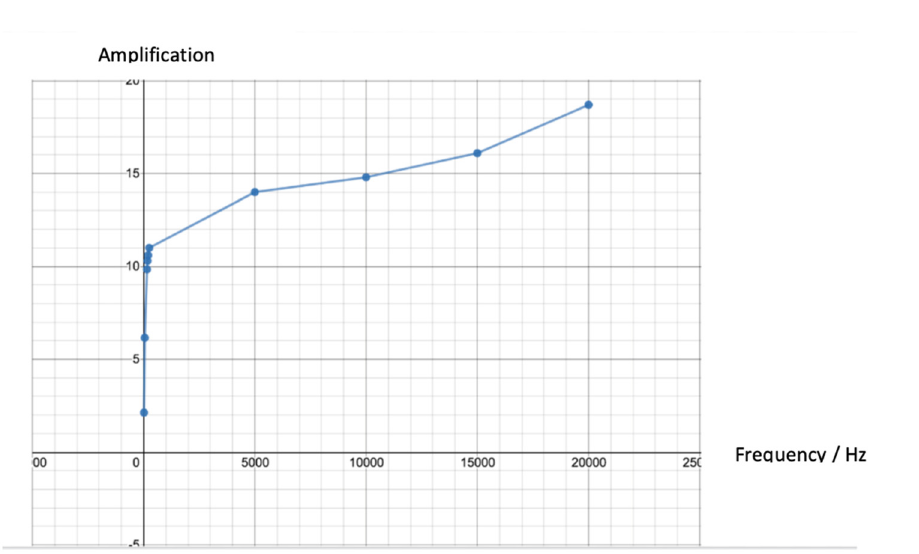
Fig 3: Amplification achieved at various